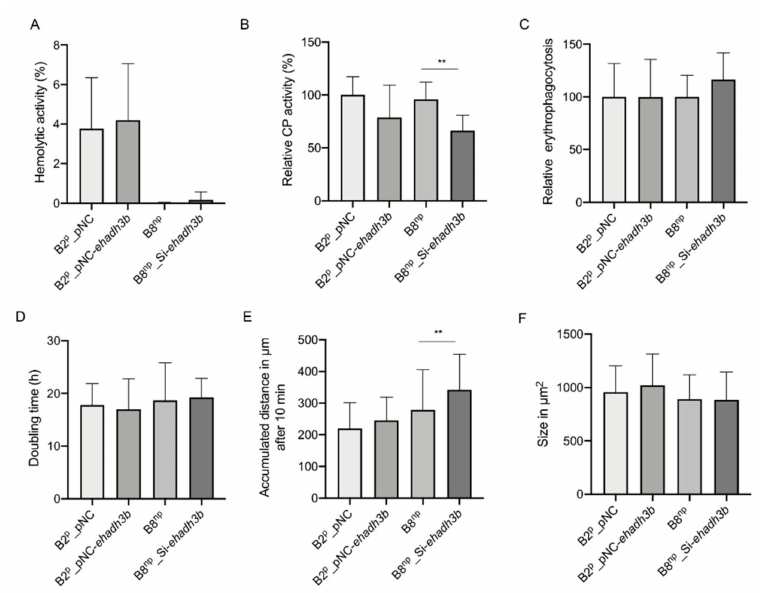
Figure 2. Phenotypical characterization of ehadh3b b overexpressing and silencing transfectants. Hemolytic activity ( A ), cysteine peptidase activity ( B ), erythrophagocytosis ( C ), doubling time ( D ), motility ( E ), and size ( F ) was determined of B2 p transfectants overexpressing ehadh3b b in comparison to the respective control amoebae transfected with pNC and of B8 np transfectants were expression of ehadh3b b was silenced using B8 np trophozoites as control. ** p <